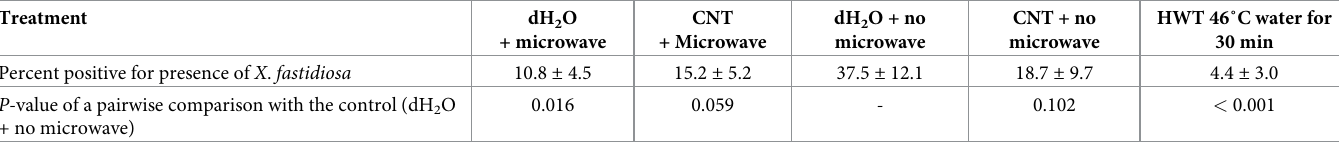
Table 2. Detection of Xylella fastidiosa in pecan scions after thermal treatments with sterile deionized water (dH 2 O) or carbon nanotube (CNT) with microwave irradiation for 3 sec in two iterations compared to the controls without microwave irradiation and the conventional hot water treatment (HWT).